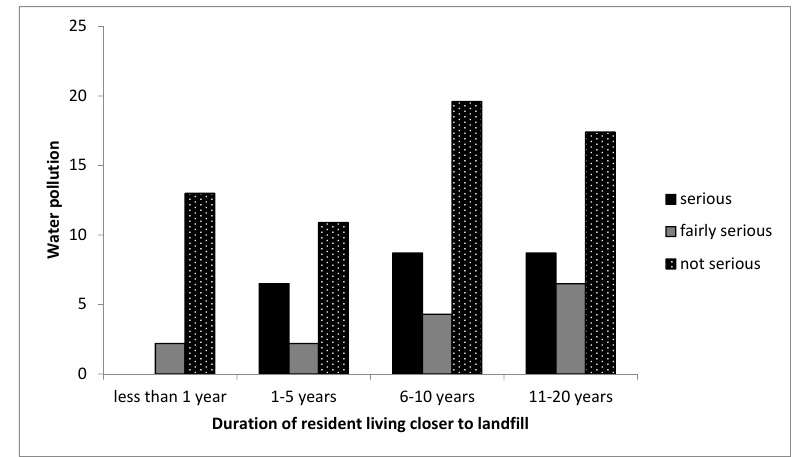
Figure 6. Cross-tabulation between the duration participants lived in the CL community and the seriousness of water pollution. Note that the no bar section in the figure indicates there was no response by the participant.